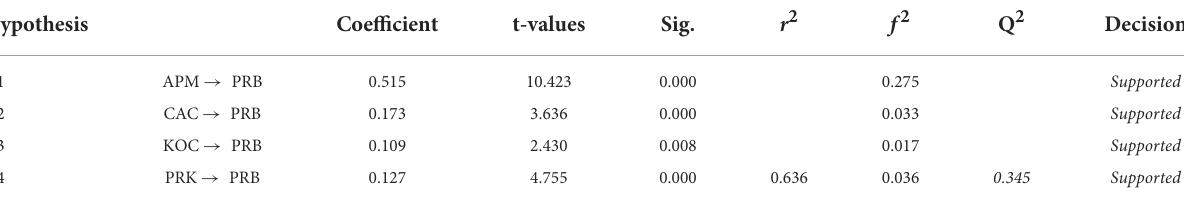
TABLE 11 Hypotheses testing.